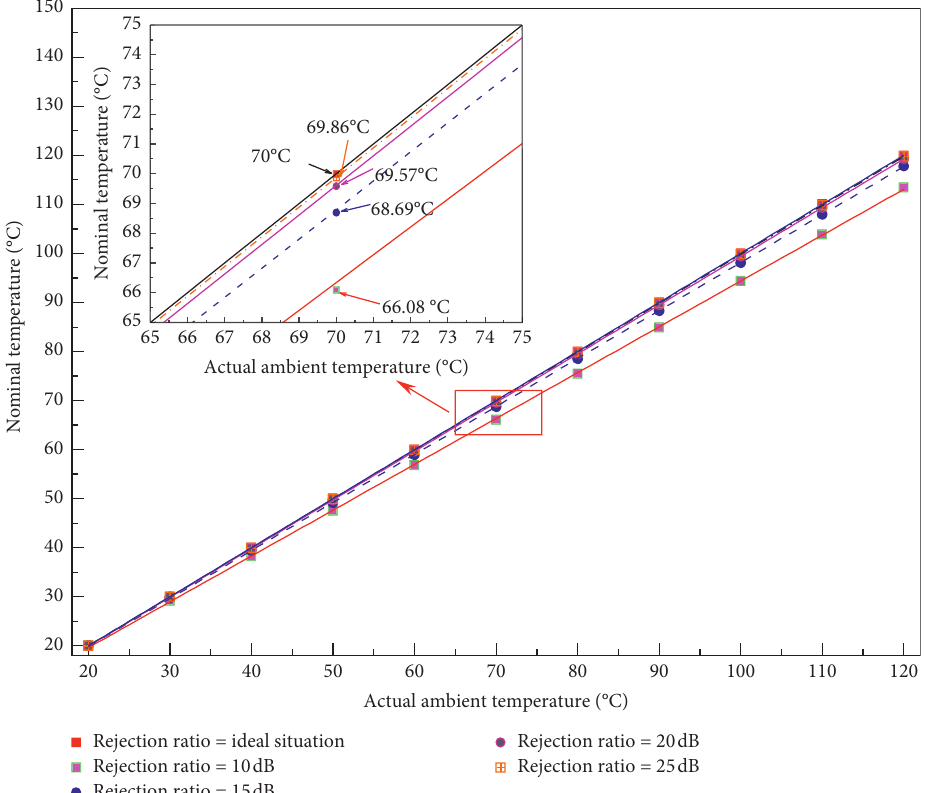
Figure 1: Simulation results of ambient temperature measurements under different rejection